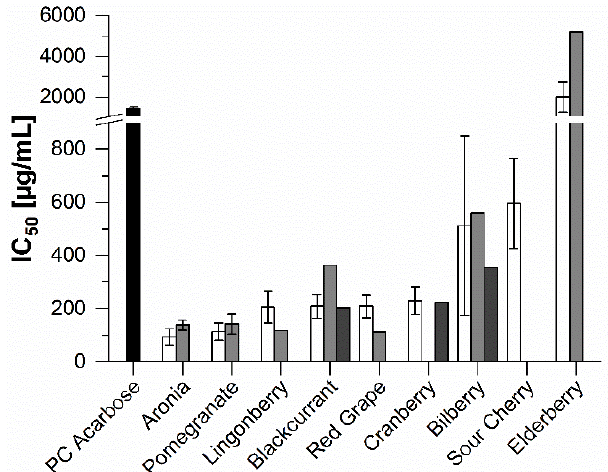
Figure 3. Inhibitory activities (IC 50 ) of the red fruit product extracts against α -glucosidase. Results are shown for extracts of direct juice (white), juice concentrate (light grey), purees (dark grey), and the positive control (PC) acarbose. Bars represent means ± SD ( n = 3)